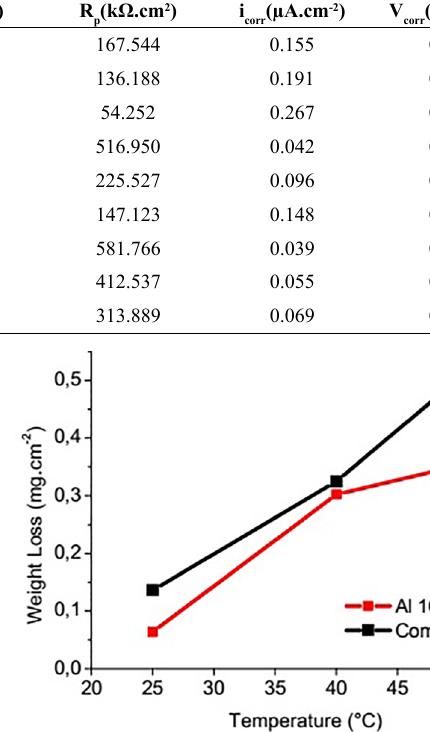
Figure 6 . Weight loss of aluminum alloys after 16 days of immersion in SJ ethanol at different